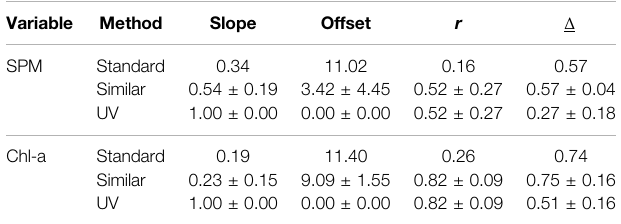
TABLE 5 | Validation of S2-MSI derivations. Similar ( μ ± σ ) is obtained from sets of independent records of similar measurements. UV is obtained after the application of unbiased